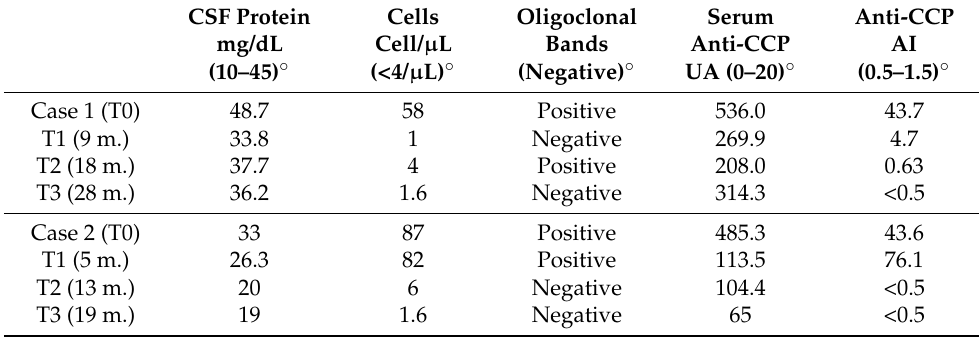
Table 1. Cerebrospinal fluid parameters in Case 1 and Case